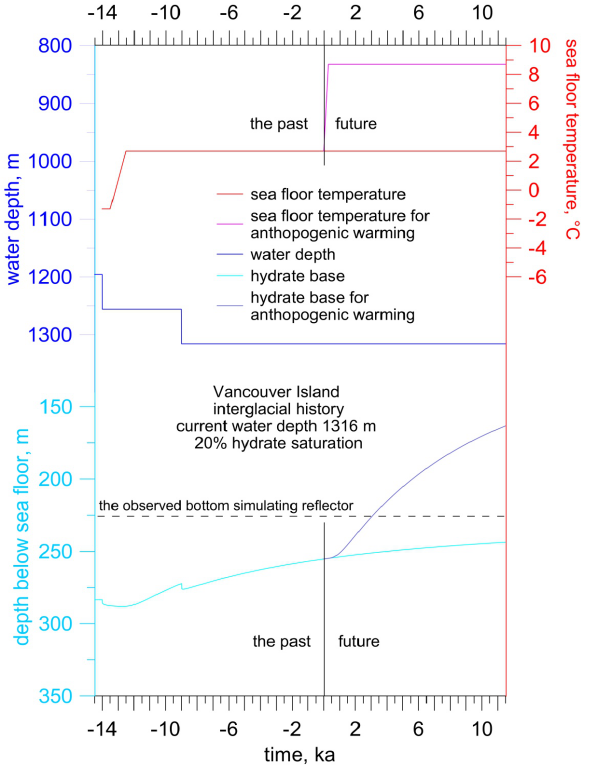
Figure 6. Simulated future GH base assuming a 6 °C sea bottom warming. The equilibrium GH layer base for temperatures of 2.7 °C and 8.7 °C are 219 m and 101 m, respectively. The model GH bases are much deeper, 243.7 m and 163.3 m, respectively, at the end of the interglacial due to effects discussed in the